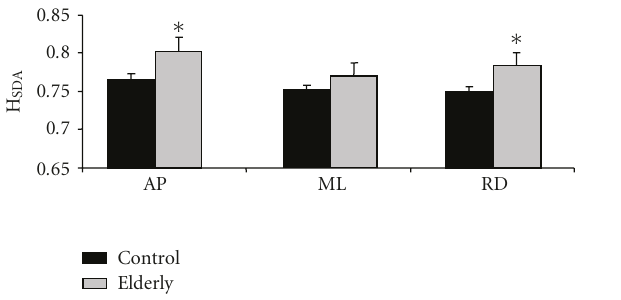
Figure 2: Estimation of the Hurst exponent using SDA for elderly and control subjects. Data are means and SD. ∗ denotes significant di ff erence from control subjects.